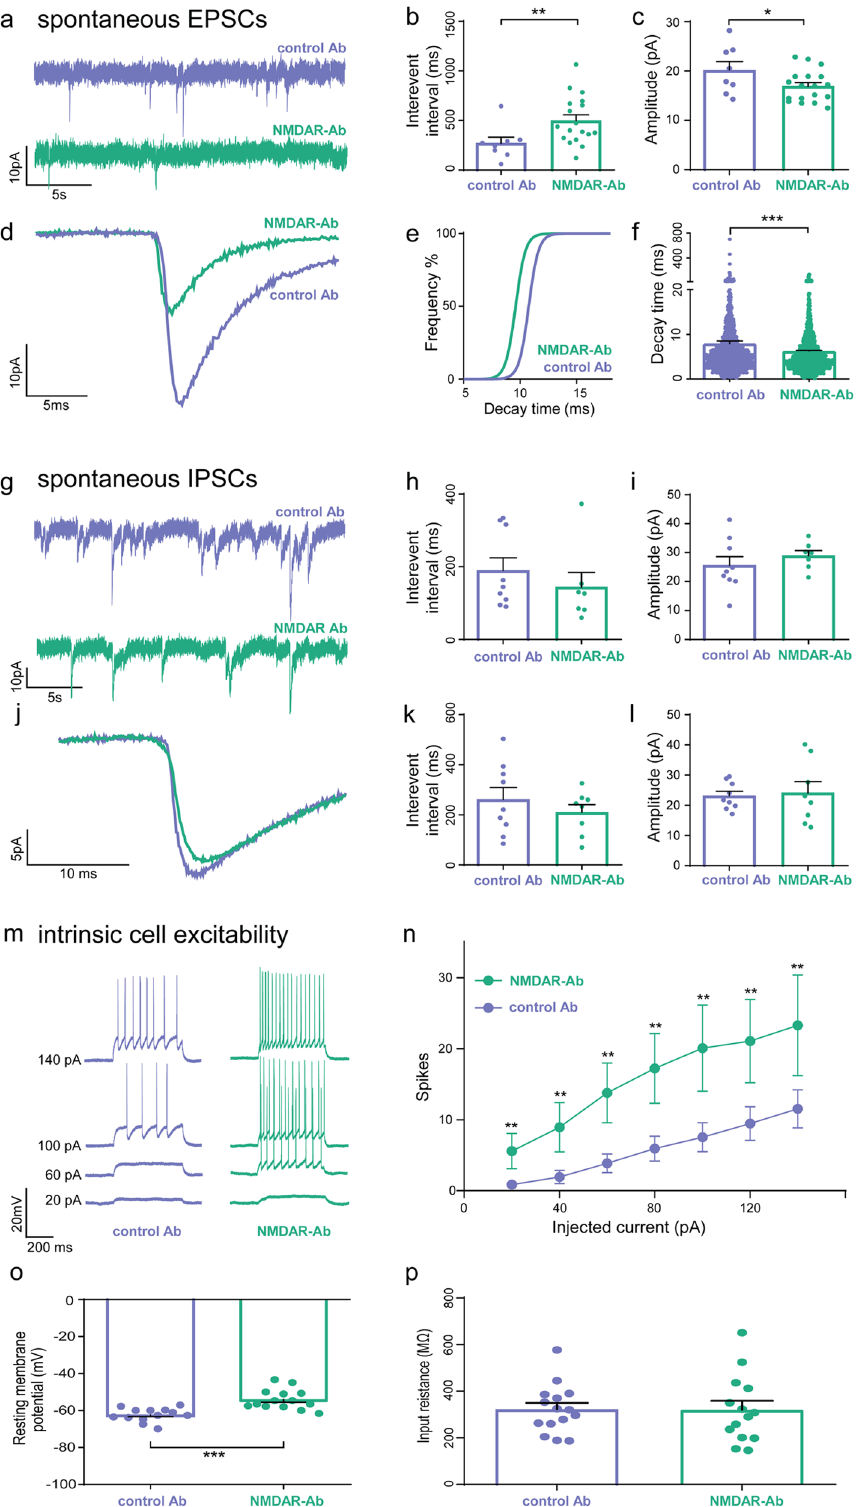
frequency bands measured compared to control antibody